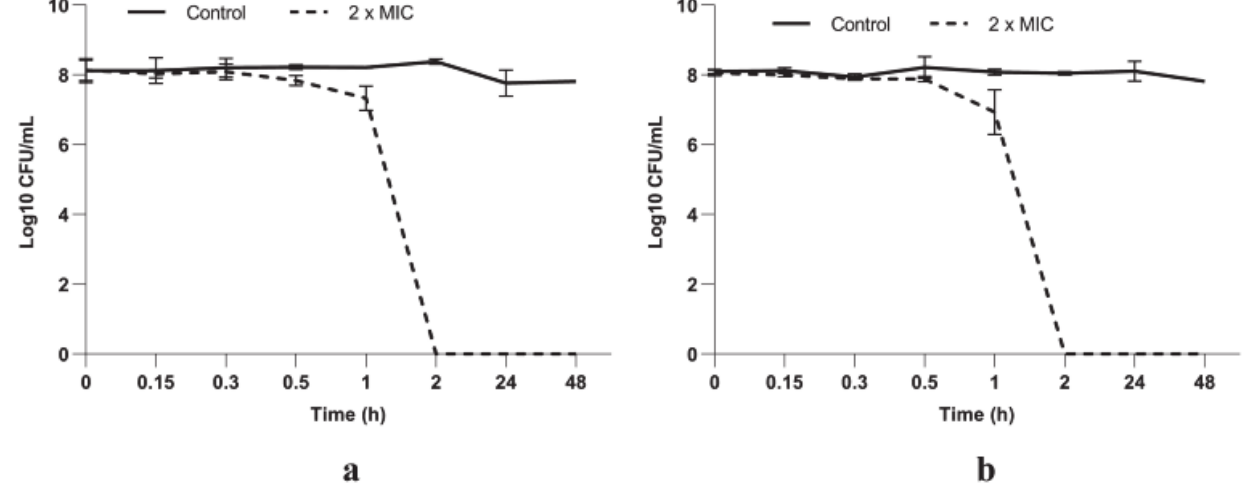
Figure 3. Time-kill curves of ( a ) PlLm and ( b ) PlLe extracts against S. aureus ATCC 25923. Bars indicate standard deviations.